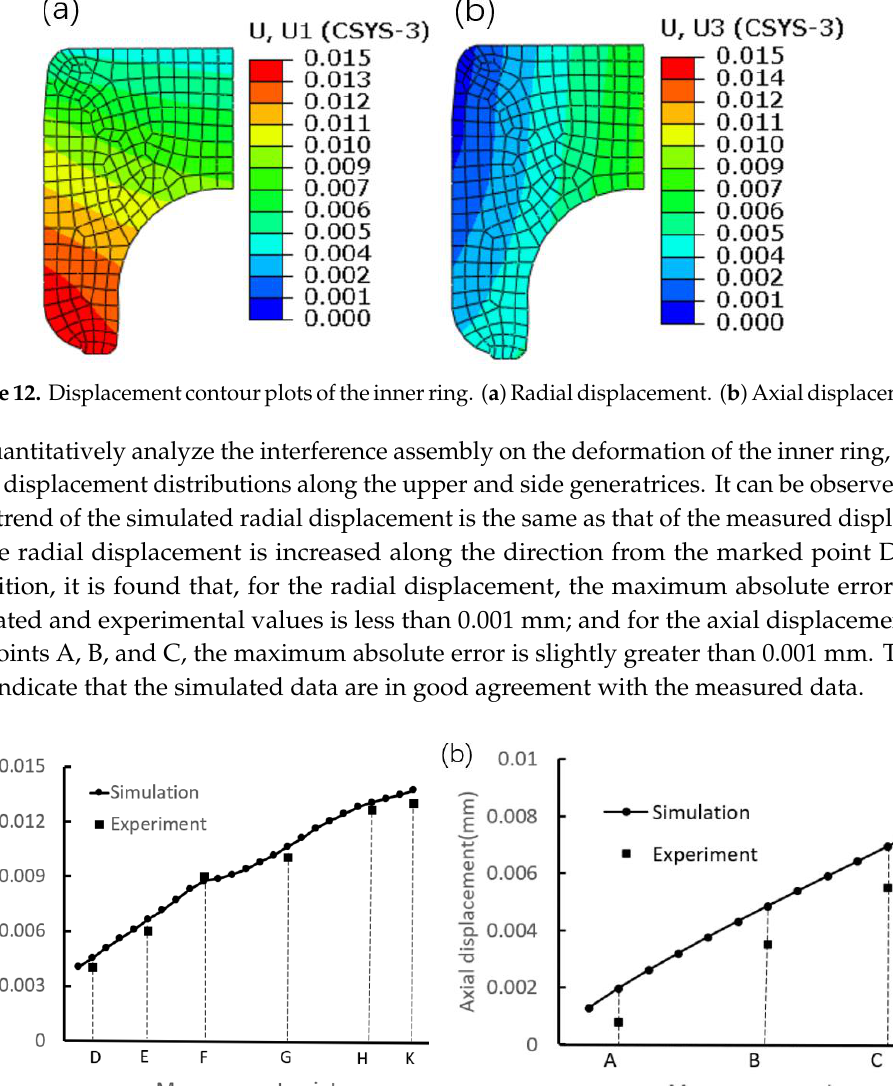
Figure 13. Displacement distributions. ( a ) Along the side generatrix. ( b ) Along the upper generatrix.